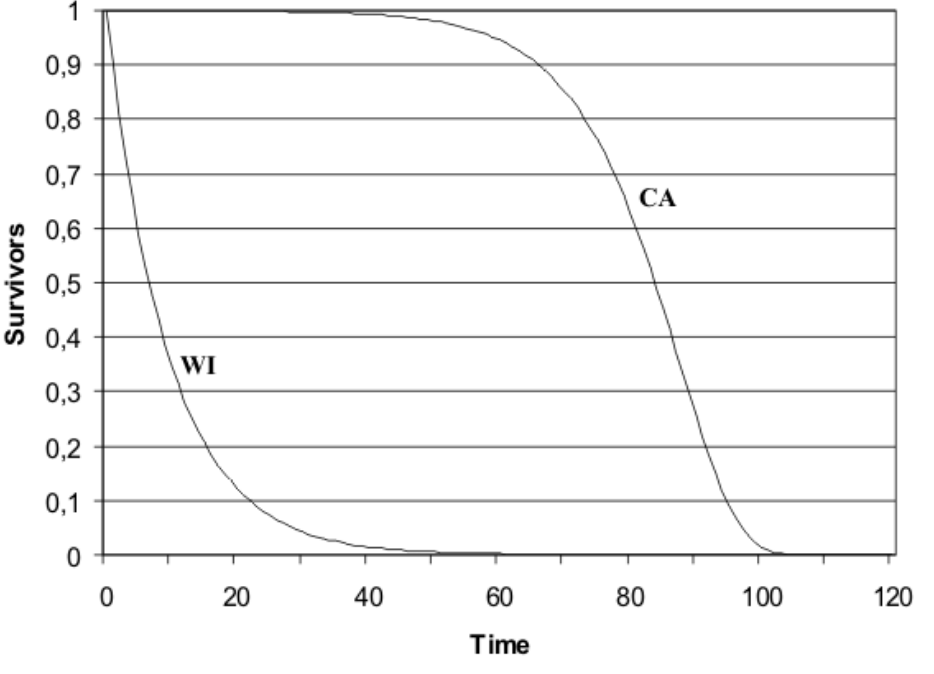
FIGURE 8. WI: life table in the wild; CA: life table in captivity. Simulation parameters: extrinsic mortality rate in the wild = 0.1; extrinsic mortality rate in captivity = 0; number of t-genes for each unity of time = 1; mutation rate from an inactive allele to a t-gene =